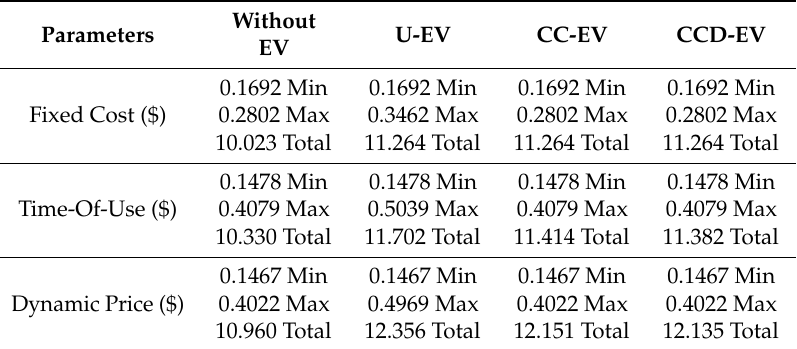
Table 2. Energy cost at home.